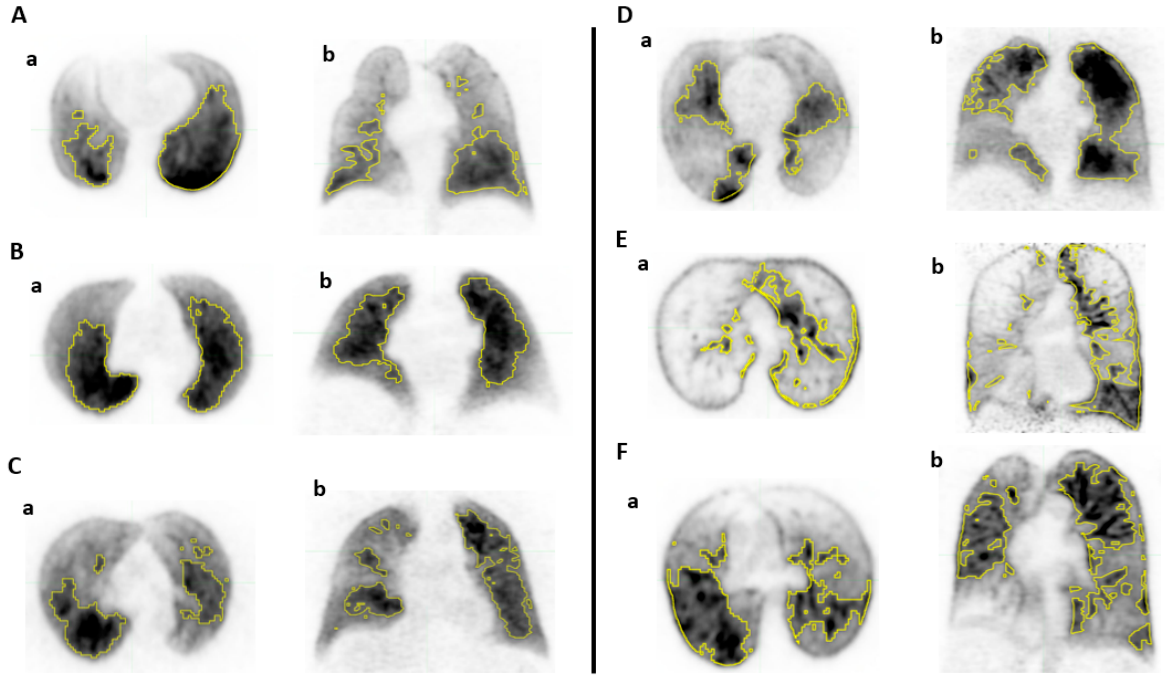
Figure 2. Illustration of perfusion volume FV50 using WLF threshold method in axial ( a ) and coronal section ( b ) in patients with normal ( A,B,C ) and abnormal ( D,E,F ) PFTs.